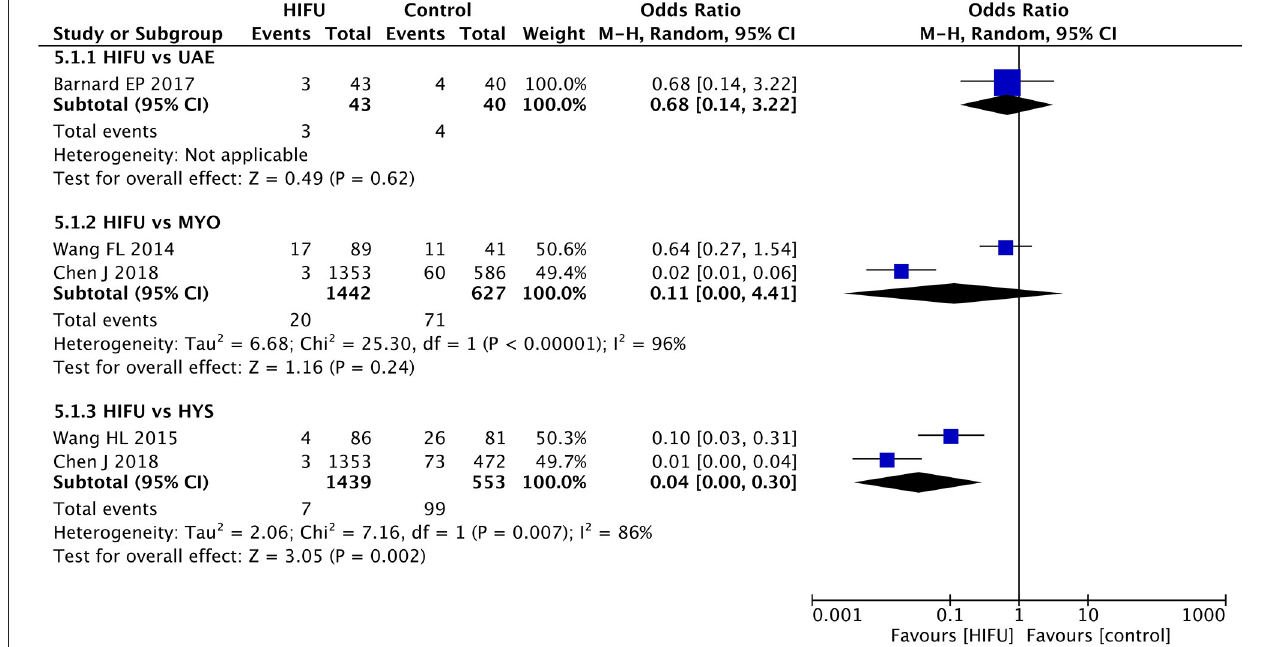
FIGURE 6 | Major adverse events of HIFU in comparison with other